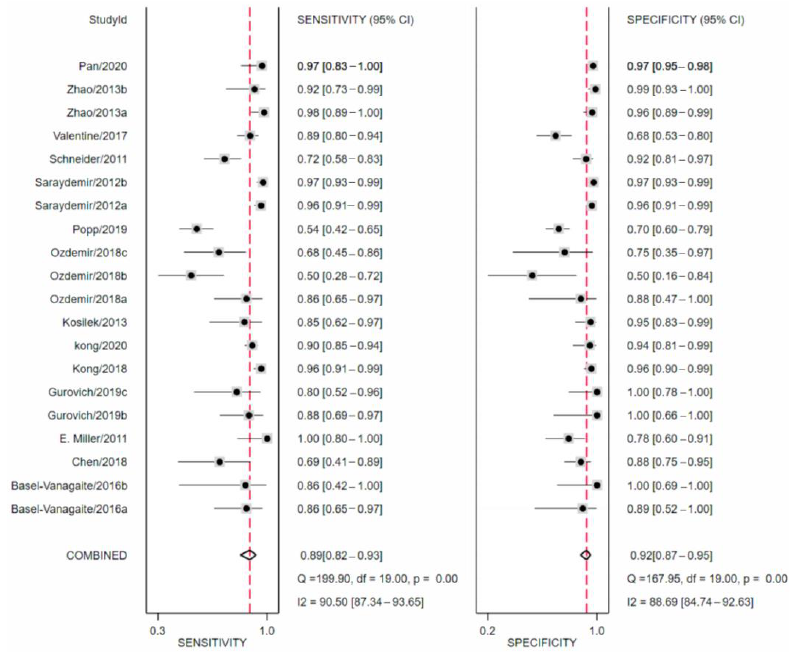
Figure 2. Forest plots of sensitivity and specificity in automatic diagnosis by facial recognition.